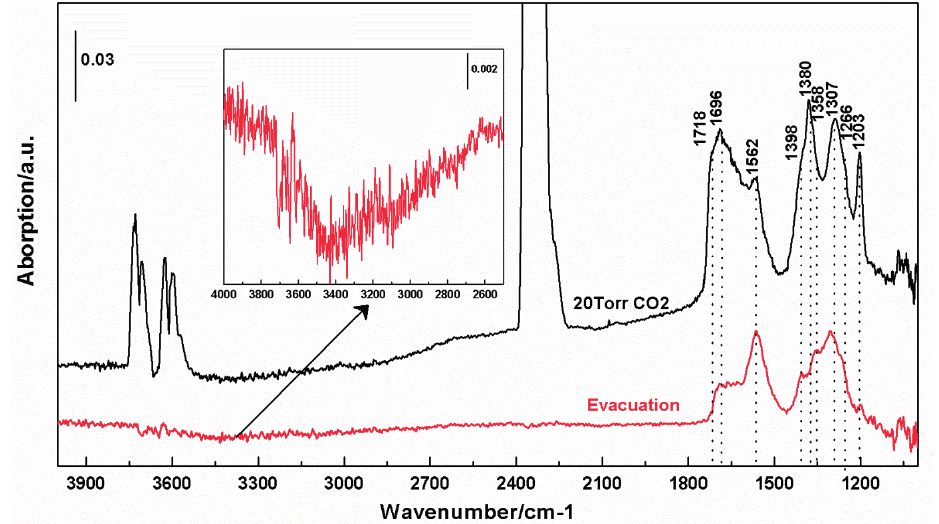
Figure 8. The upper trace is an in situ FT-IR spectrum of the cTiNT-O 2 -H 2 exposed to 20 Torr of CO 2 for 30 min at room temperature. The lower trace is the same sample after exposure to vacuum at room temperature. The background for these spectra is the c-TiNT-O 2 -H 2 . The insert is a blow-up of the 4000 to ~2400 cm − 1